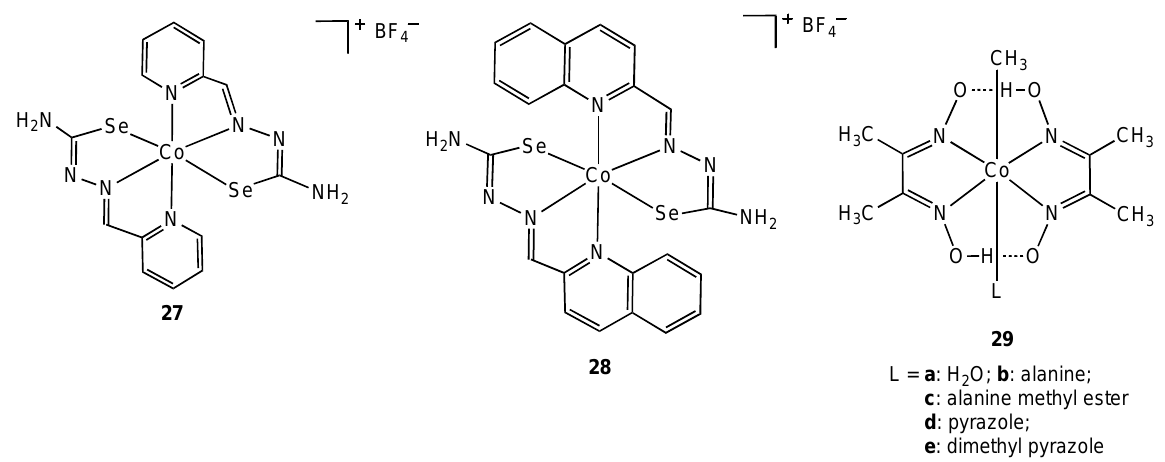
Figure 15. Selenium containing and organometallic cobalt(III)